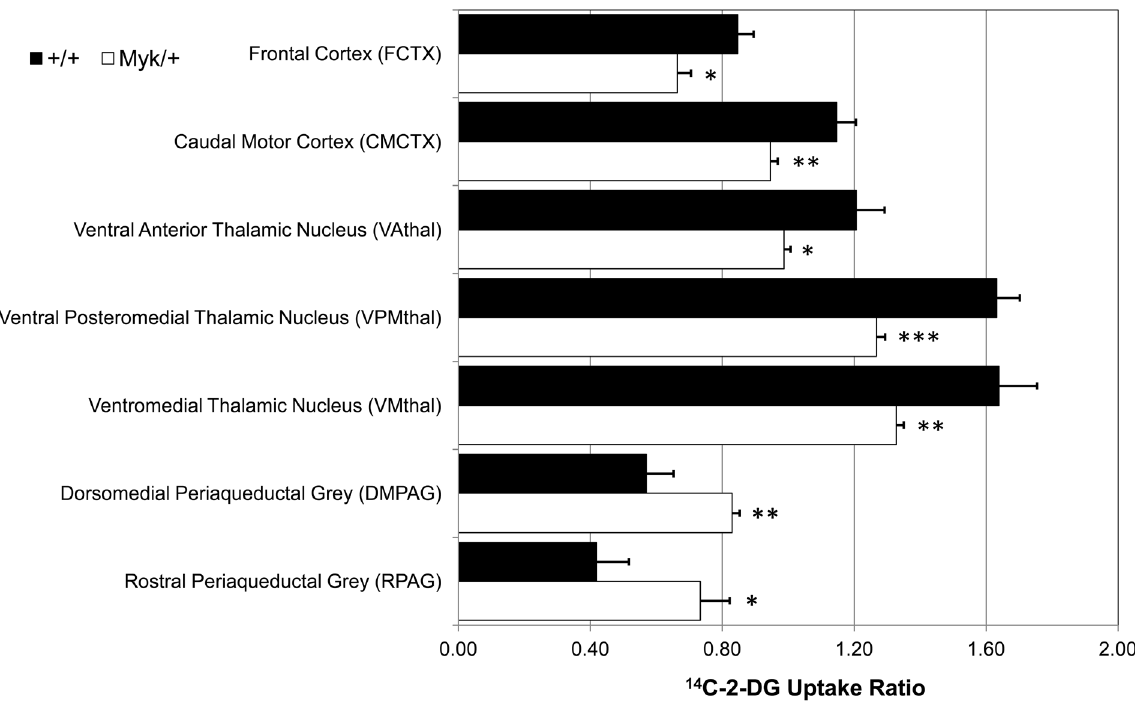
Figure 4. Significant alterations in overt local cerebral glucose utilization in Myk / + mice. Data shown as mean 6 SEM of the 14 C-2-DG uptake ratio. *denotes P , 0.05, **denotes P , 0.01 and ***denotes P , 0.001 significant genotype effect (Welch’s t -test).